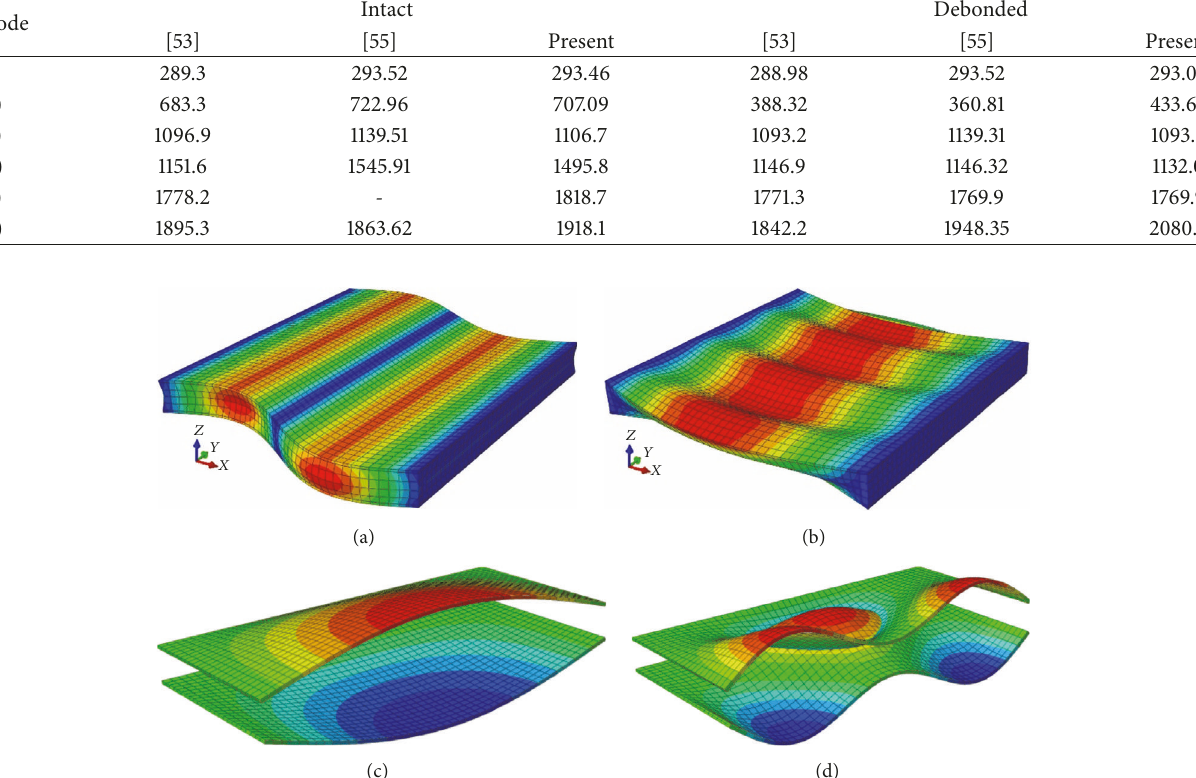
Figure 8: Contour plots of the mode shapes of sandwich plate with flexible core: (a) an in-plane mode; (b) a shear mode; (c) and (d) pumping modes [10].